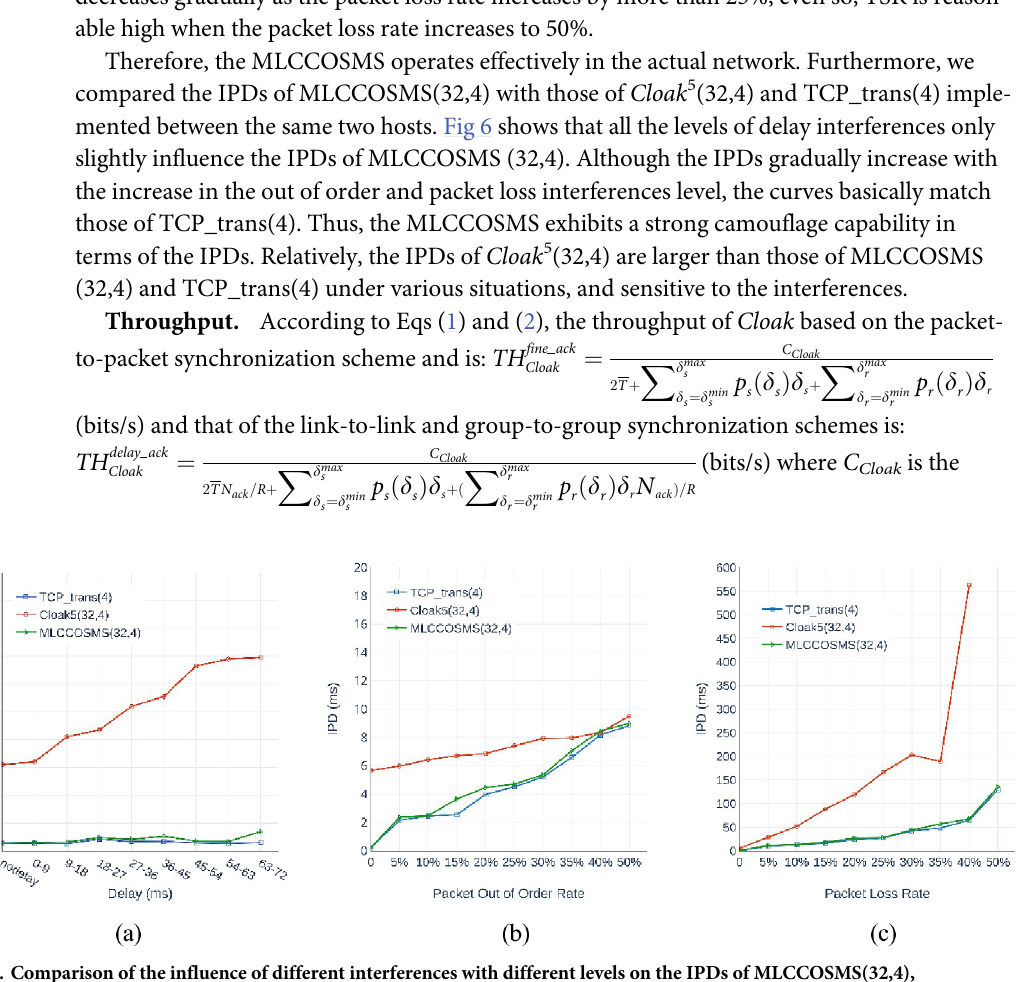
Fig 6. Comparison of the influence of different interferences with different levels on the IPDs of MLCCOSMS(32,4), Cloak 5 (32,4), and TCP_trans(4). (a) interference by delays. (b) interference by out of order mechanisms. (c) interference by packet loss.